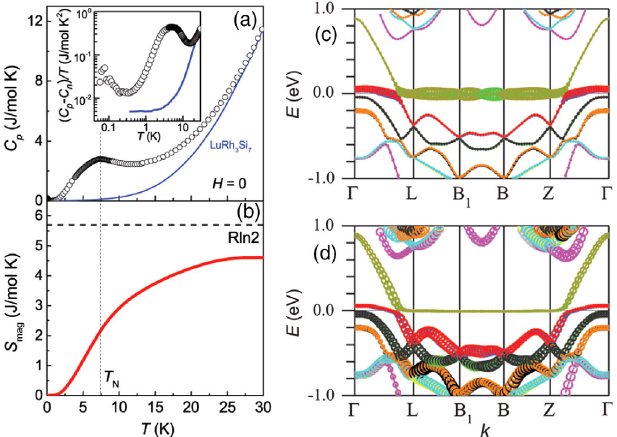
FIG. 2. (a) H ¼ 0 C p ð T Þ for YbRh 3 Si 7 (full circles) and its nonmagnetic analogue (line) LuRh 3 Si 7 . Inset: Log-log plot of ð C − C Þ =T vs T , where C p n n is the nuclear contribution to the ð T Þ . (c) Band structure of specific heat. (b) Magnetic entropy S mag YbRh 3 Si 7 with so-called “ fat bands ” highlighting the contribu- tion from Yb f orbitals and (d) Rh and Si atoms. Thicker sections of the bands represent a larger partial contribution of the respective